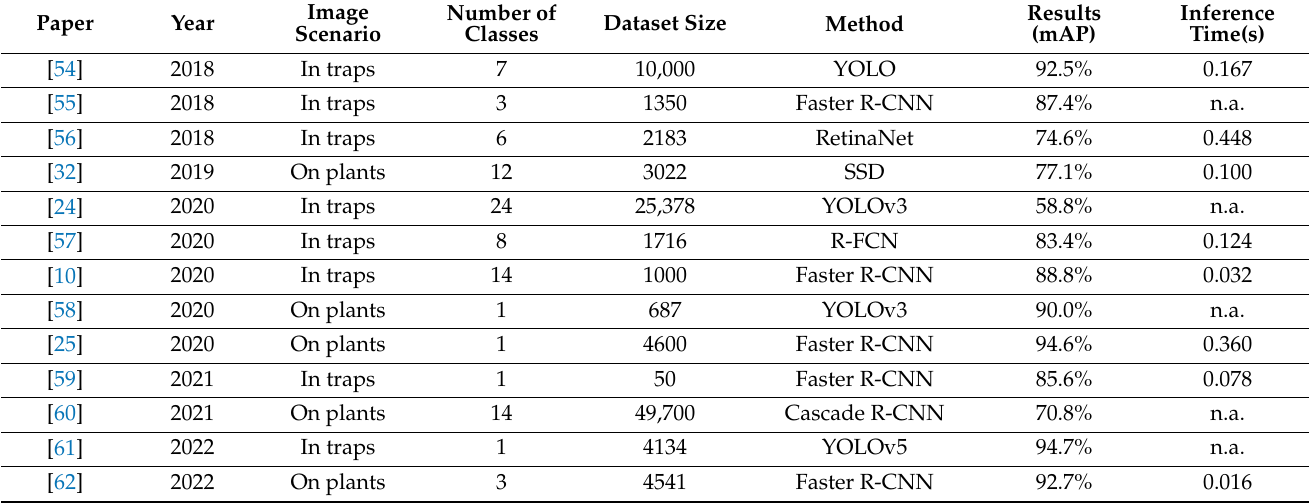
Table 3. Study analysis of detection with standard detectors.